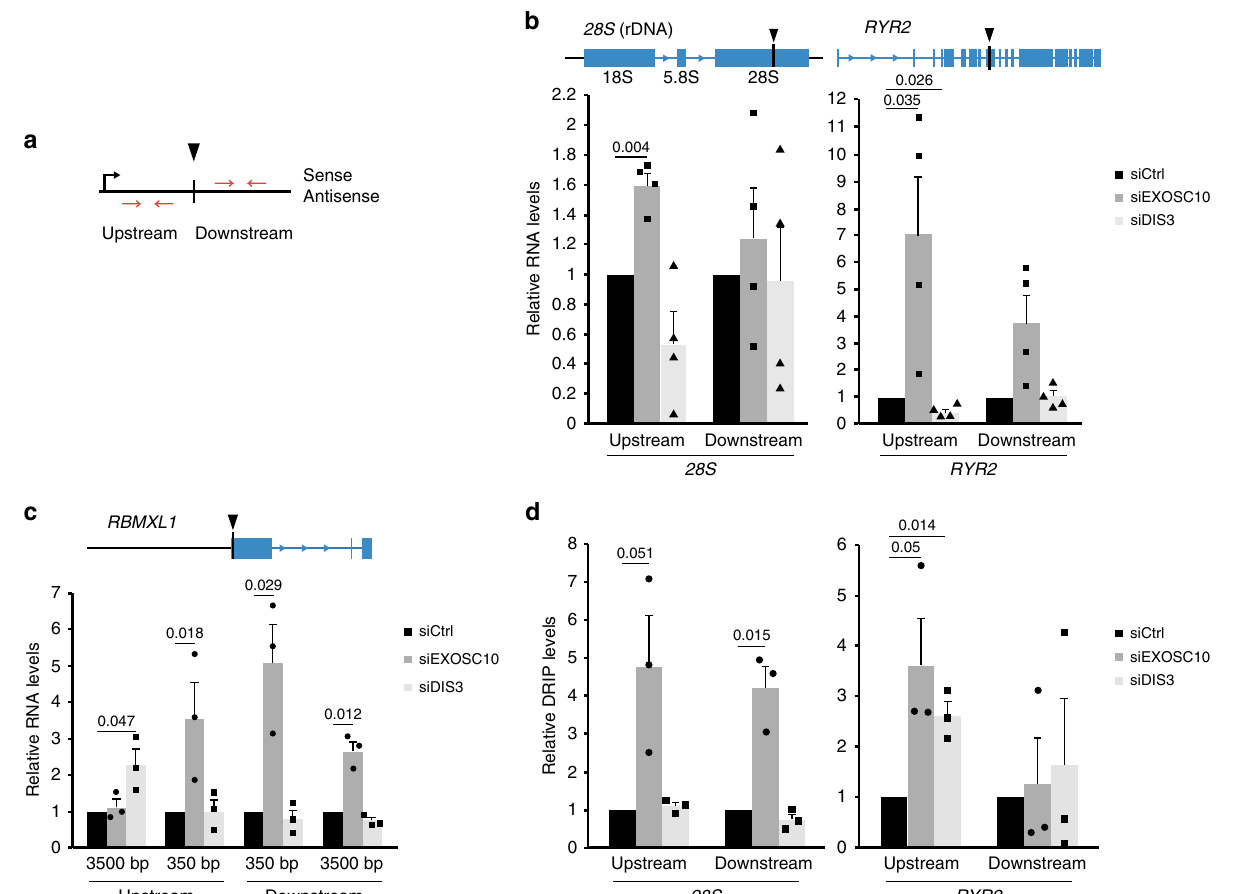
Fig. 4 DilncRNA levels are increased upon depletion of EXOSC10. a Schematic drawing of a DSB showing the nomenclature used to describe the origin of dilncRNAs transcribed from DSB- fl anking sequences. b SsRT-qPCR experiments were carried out to analyse the levels of upstream antisense and downstream sense (at 500 bp from the DSB) RNAs in the 28S and RYR2 genes in HeLa cells, as indicated, 20 h after transfection with the pOPRSVI/MCS-I- PpoI plasmid for I - PpoI expression. The graph shows the ratios cut/uncut for siEXOSC10 and siDIS3 samples, compared to the ratios observed in the control cells (siCtrl). RNA levels were normalized to ARPP. c DIvA cells were transfected with siCtrl, siEXOSC10, or siDIS3 and incubated for 4 h with 300 nM 4-OHT before RNA analysis. The graph shows relative RNA levels quanti fi ed by ssRT-qPCR as in b . d DRIP-qPCR was performed in HeLa cells 20 h after transfection with the pOPRSVI/MCS-I-PpoI plasmid. The graph shows the relative DRIP-qPCR levels in cells treated with either siEXOSC10 or siDIS3 compared to control cells (siCtrl). DRIP-qPCR levels were normalized to GADPH. Error bars show s.e.m. from four independent experiments in b and d , and three in c . Statistical testing was done using a one-sample Student ’ s t -test and signi fi cant p -values are shown in the fi gure. Source data for Fig. 2a – c are provided as a Source Data fi